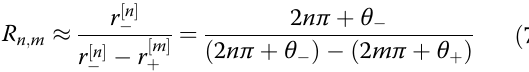
and R (cid:4) 1 ; 0 for each coupling fi eld detuning Δ c , as shown in Fig. 4b, and accordingly reconstruct the Zak phases in Fig. 4c, in comparison with the theoretical prediction as indicated by the dashed lines. As an example, we show the WSLs with θ (cid:4) ¼ 0 : 3 π , θ þ ¼ 0 : 7 π in Fig. 4d and with θ ¼ 0 : 4 π , θ ¼ 0 : 6 π in Fig. 4e. The corresponding (cid:4) þ absorption and re fl ection spectra are plotted in Fig. 4f, g,